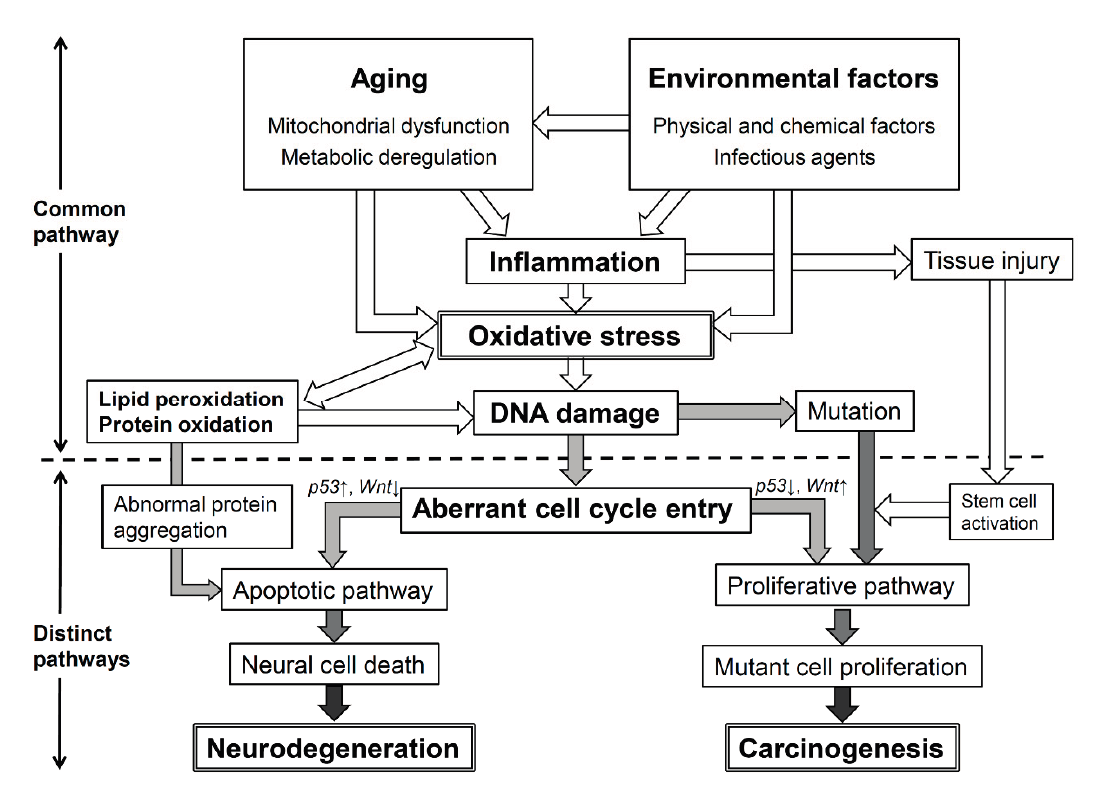
Figure 5. Roles of oxidative stress in neurodegenerative diseases and